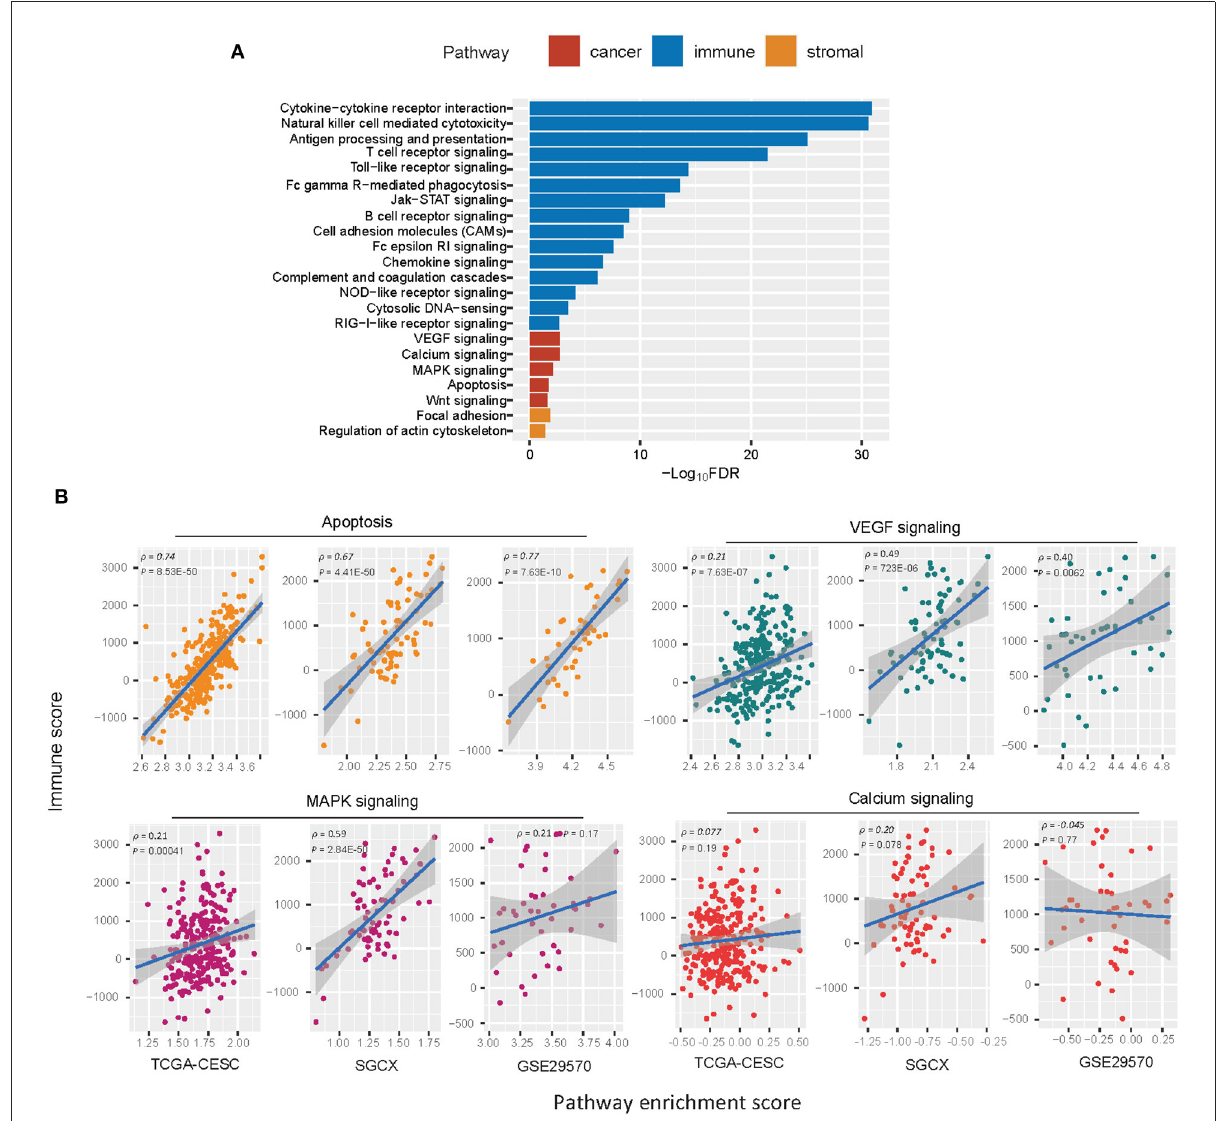
FIGURE4 KEGG pathways more enriched in Immunity-H vs. Immunity-L. (A) The cancer, immune, and stroma-associated pathways showing significantly higher enrichment in Immunity-H (FDR < 0.05). FDR, false discovery rate. (B) Spearman correlations between the enrichment scores of the cancer-associated pathways upregulated in Immunity-H and immune scores in HPV + cervical cancer.